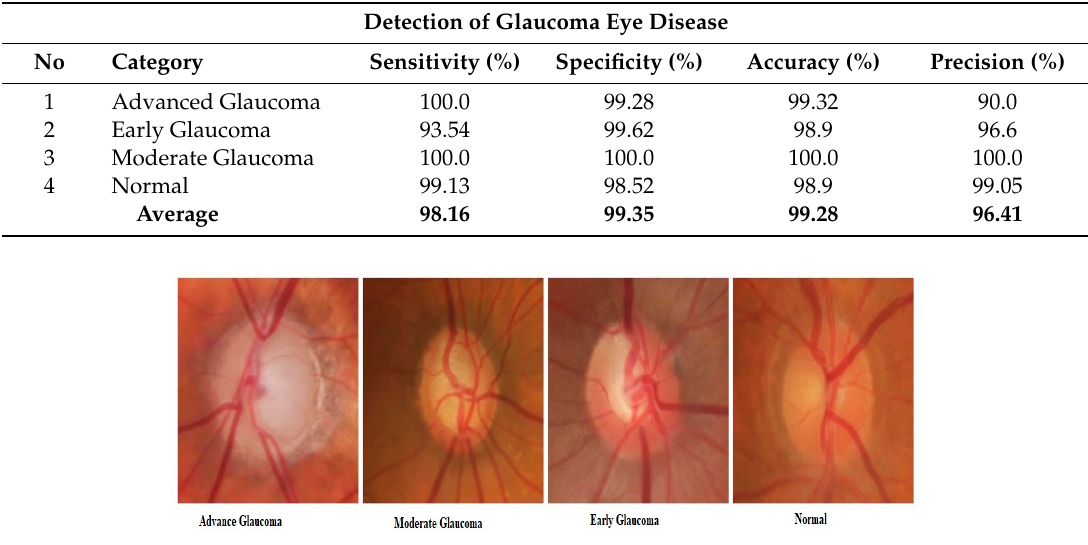
Figure 5. Glaucoma Stages.